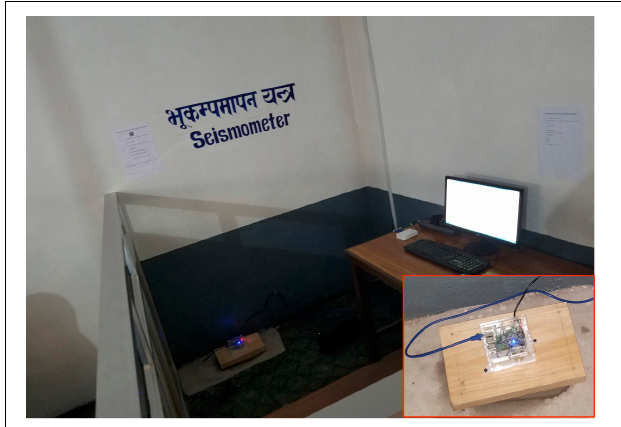
FIGURE 6 | Example of the setting of an installed seismometer, in Shree Siddha Baba Secondary School, Gulmi district. The sensor is installed on the ground floor by making a partition in the Accounting Room; it is fixed to a wooden block which is itself fixed into a ca. 2 cm thick cemented base on the ground (inset). The station is connected to a desktop computer for real-time data visualization via the jAmaSeis (Drago et al., 2009) software. Detailed information on how to visualize waveforms on a smartphone using the EQInfo app is printed on the wall (A4 paper). The word “Seismometer” is written in on the wall in Nepali (and English)